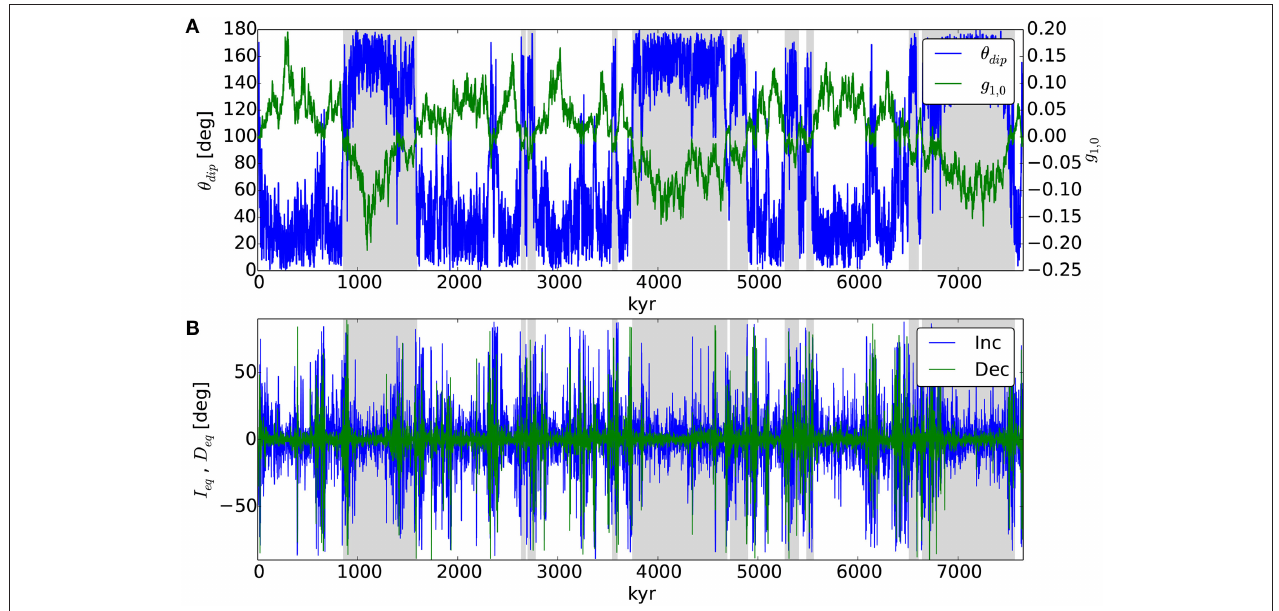
FIGURE 1 | Time series of model 4 ( dT / dr i = 4): (A) dipole co-latitude θ dip (left axis) and axial dipole Gauss coefficient g 1,0 (right axis). Background shading gray (white) denotes normal (reversed) polarity chrons. (B) Magnetic inclination I eq and declination D eq of synthetic observations at equator ( θ = 90 ◦ , φ = 0).